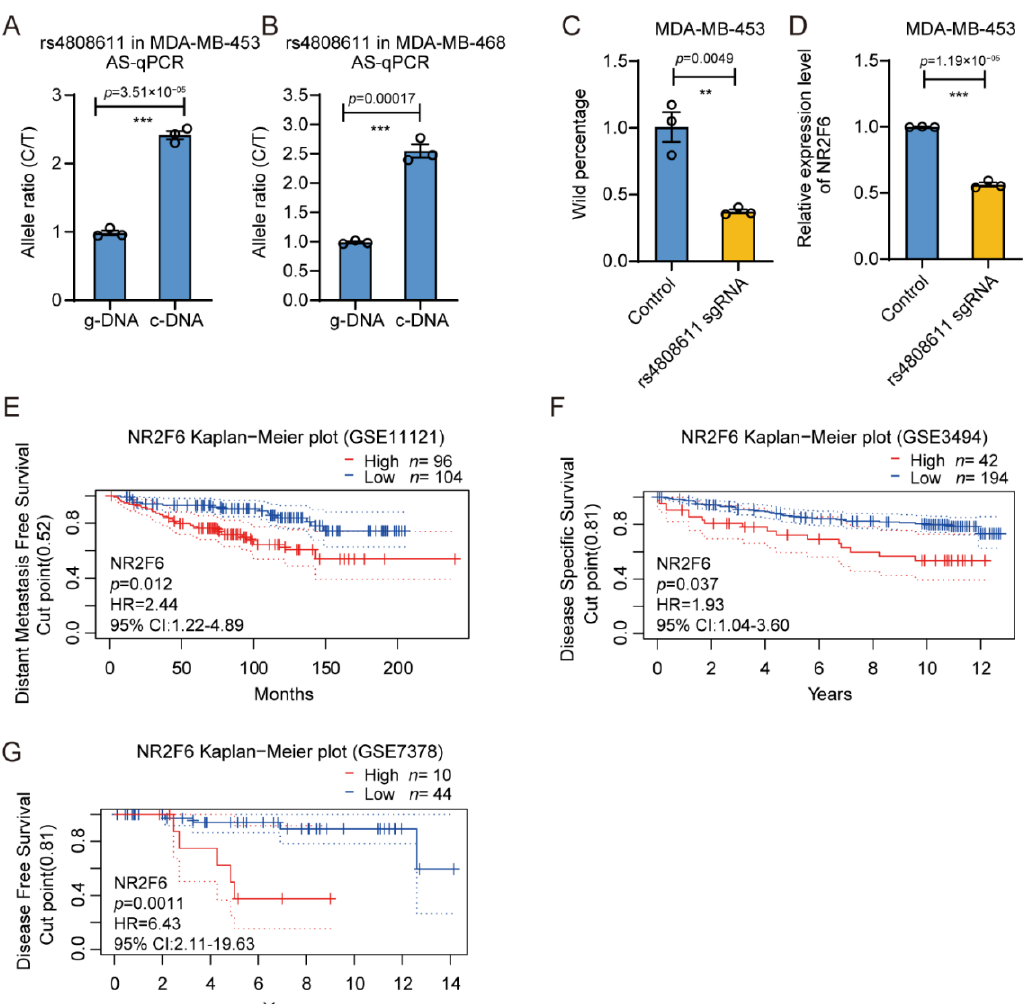
Figure 6. rs4808611 affects gene expression of NR2F6 . ( A , B ) Allele preference in the transcription of the rs4808611 region in the MDA ‐ MB ‐ 453 ( A ) and MDA ‐ MB ‐ 468 ( B ) cells was determined by AS ‐ qPCR. Mean ± SD of three technical replicates. *** p < 0.001, two-tailed Student’s t -test. ( C ) The frequency of CRISPR/Cas9 genome editing on the rs4808611 region, determined by getPCR analysis in MDA-MB-453 cells. Mean ± SD of three technical replicates. ** p < 0.01, two-tailed Student’s t -test. ( D ) Gene expression level of NR2F6 in the genome-edited MDA-MB-453 cells determined by RT-qPCR and normalized with ACTB expression. Mean ± SD of three technical replicates. *** p < 0.001, two-tailed Student’s t -test. ( E ) Kaplan–Meier plot showing the distant metastasis-free survival of the breast cancer patients from the GEO cohort (GSE11121), stratified according to the expression level of gene NR2F6 (Cut point = 0.52). ( F ) Kaplan–Meier plot showing the disease-specific survival of breast cancer patients from the GEO cohort (GSE3494), stratified by the expression level of gene NR2F6 with a cut point of 0.81. ( G ) Kaplan–Meier plot showing the disease-free survival of breast cancer patients in the GEO cohort (GSE7378), grouped by the expression level of gene NR2F6 with a cut point of 0.81. The HR was provided with a 95% confidence interval, and p values were calculated with the log-rank test for ( E – G